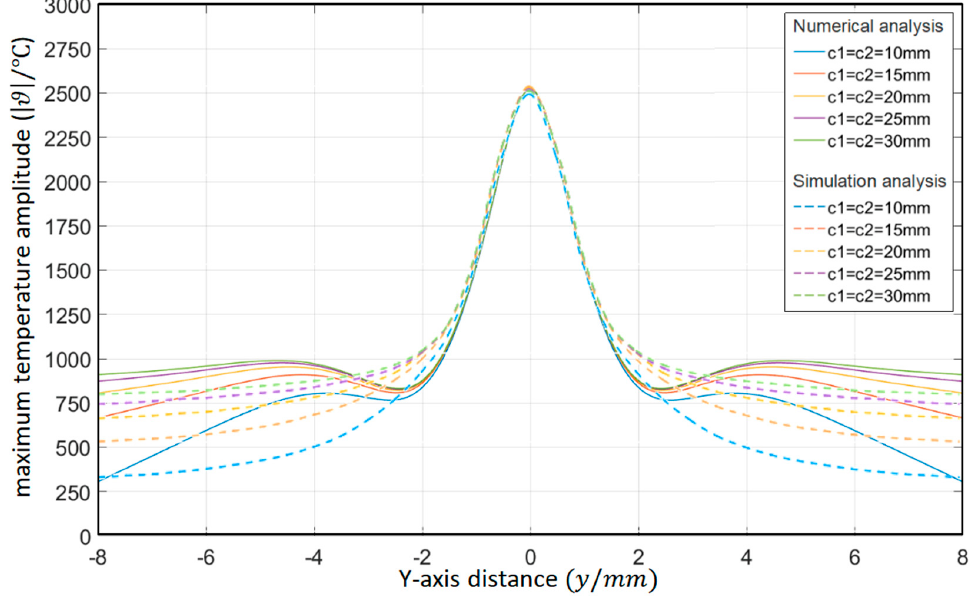
Figure 4. Surface temperature distribution diagram of platinum rhodium bushing: ( a ) c 1 = c 2 = 10